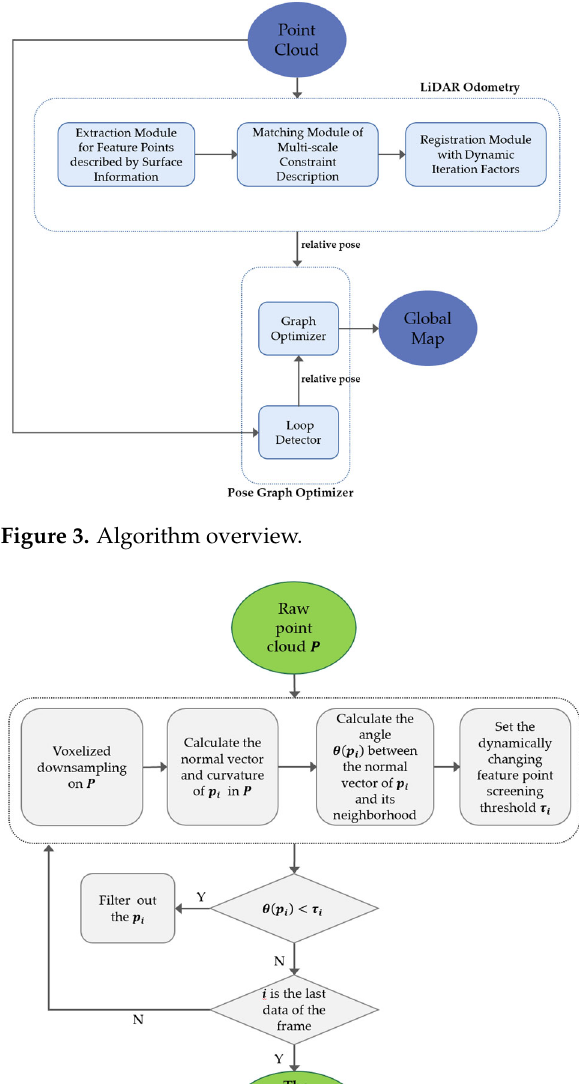
Figure 3. Algorithm overview.